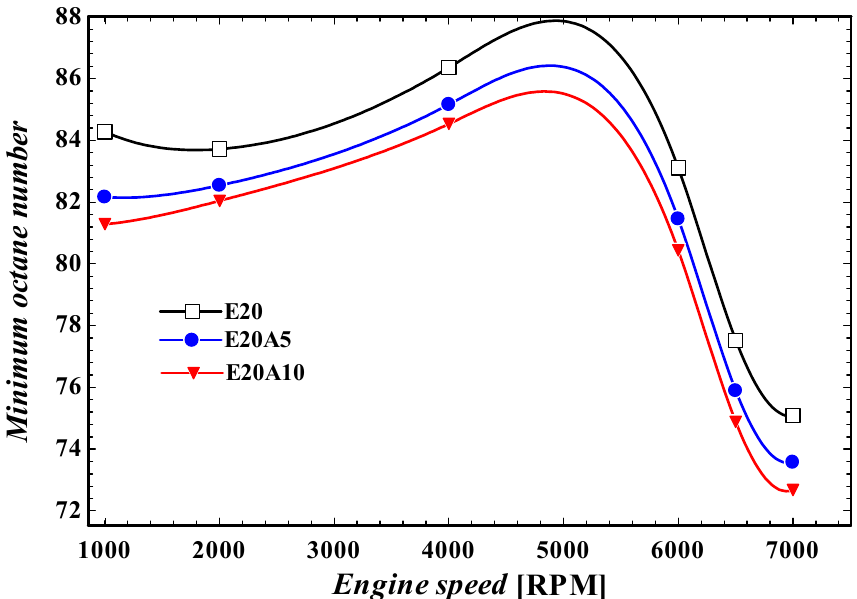
Figure 15. Minimum fuel octane number requirement at various engine speeds at different fractions of ammonia.